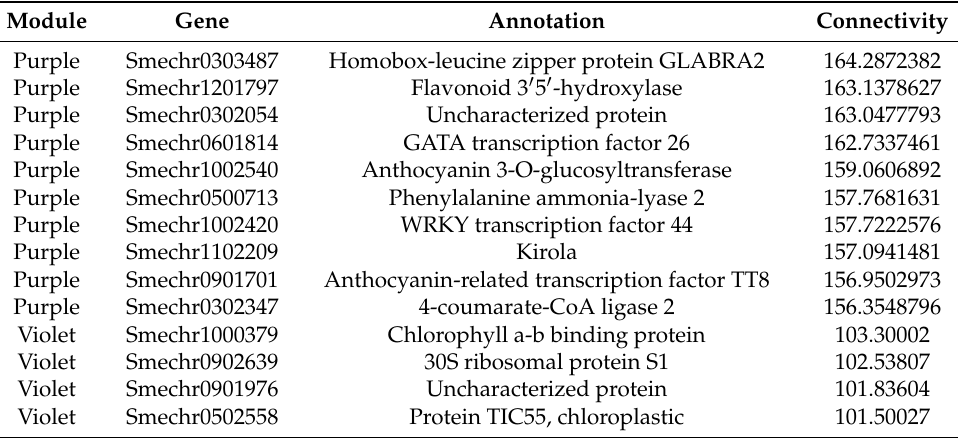
Figure 9. Gene network and key candidate genes involved in anthocyanin biosynthesis, identified by WGCNA. ( A ) Module–trait associations based on Pearson correlations; ( B ) Gene network of the hub genes in the purple module, which were positively correlated with the total anthocyanin content ( r 2 = 0.84, p = 1 × 10 − 4 ); ( C ) The effect of SmGL2 , SmGATA26, and SmWRKY44 silencing in VIGS eggplant fruits. Table 3. The hub genes detected in the purple and violet